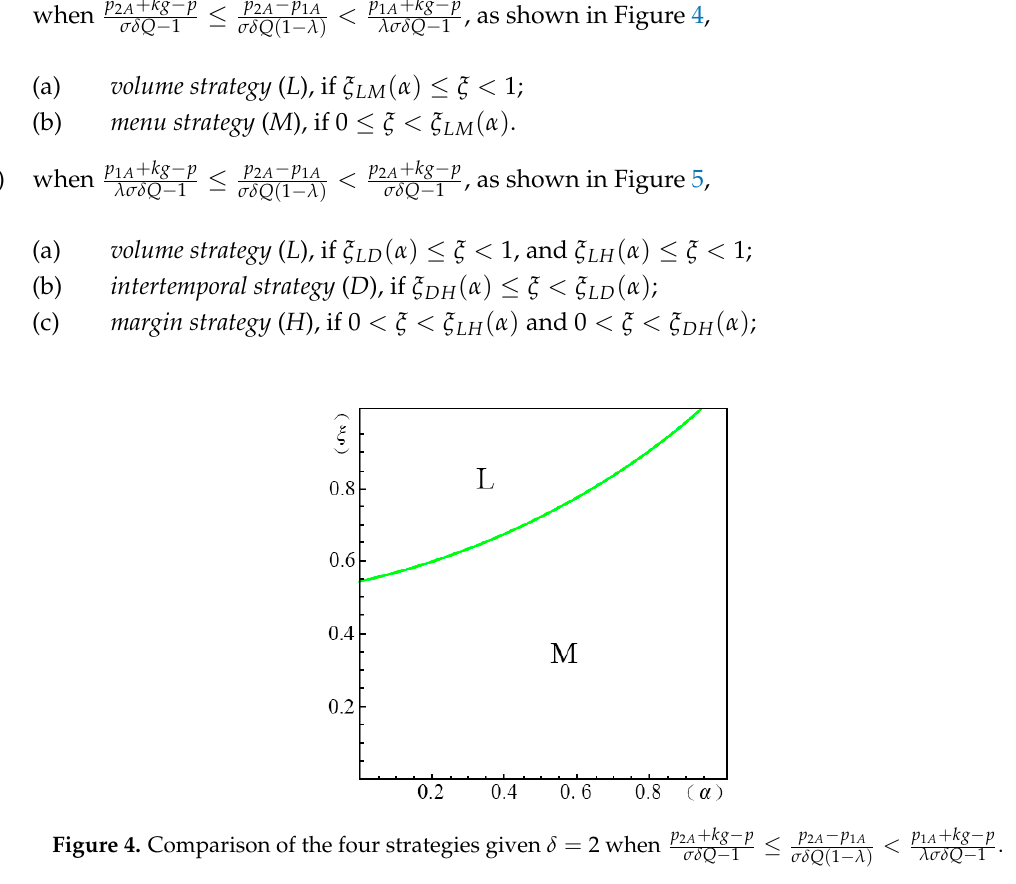
Figure 4. Comparison of the four strategies given (cid:2012) (cid:3404) 2 when (cid:3043) (cid:3118)(cid:3250)